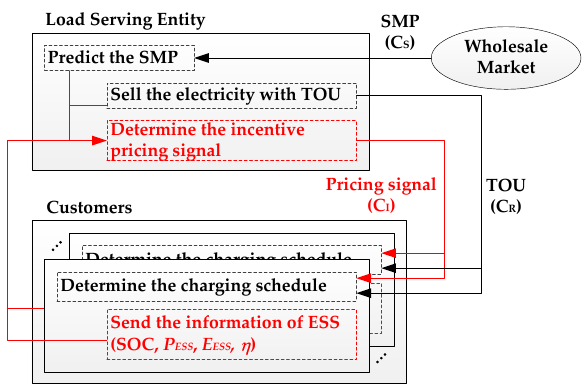
Figure 2. Process of determining the ESS charging schedule. SMP: system marginal price; TOU: time-of-use; and SOC : state of charge.